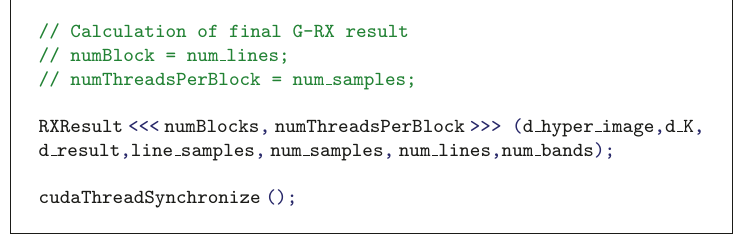
Figure 11: Portion of code which calls the CUDA kernel RXResult designed to obtain a final set of targets (in parallel) in the G-RX implementation.